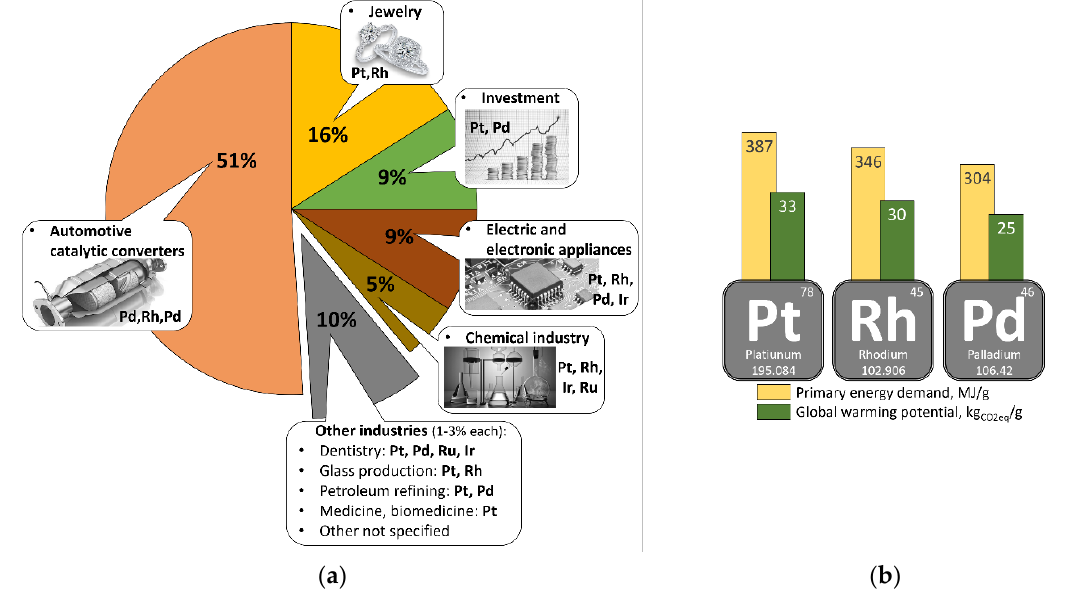
Figure 3. PGEs in use: ( a ) The main industrial applications of PGEs [5,40]; ( b ) Primary energy demand and global warming potential for Pt, Rh, and Pd [40]. Minerals 2020 , 10 , x FOR PEER REVIEW